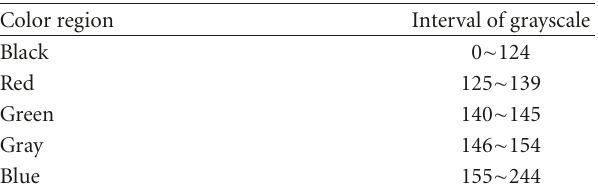
Table 1: The intervals of grayscale values are listed for color regions in Figure